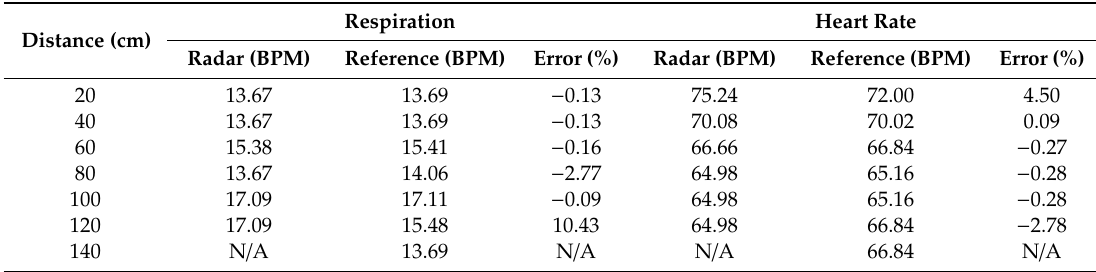
Table 5. Measured respiration and heart rates for one subject located at various distances by using the proposed radar sensor and the reference piezoelectric and ECG sensors.